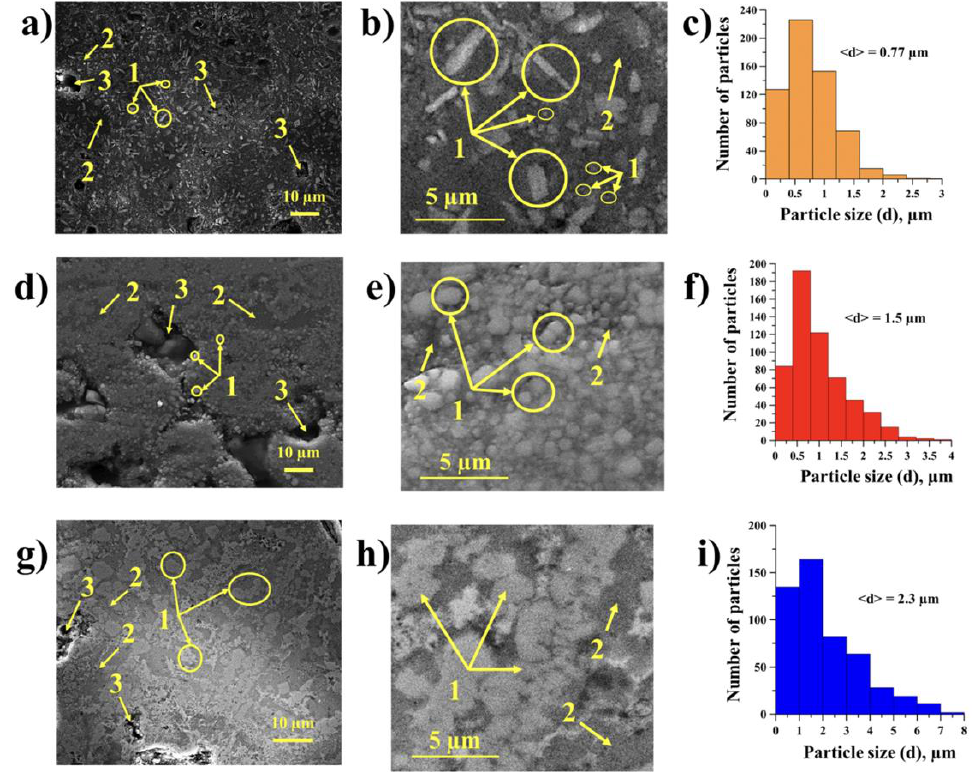
Figure 7. Backscattered SEM images of the SHS products and distribution of TiB 2 particles in the SHS products obtained from the Al-Ti-B powder mixture after: ( a – c ) 60 s, ( d – f ) 180 s, and ( g – i ) 900 s of mechanical activation. Region 1: TiB 2 particles; region 2: aluminum matrix; region 3: pores.